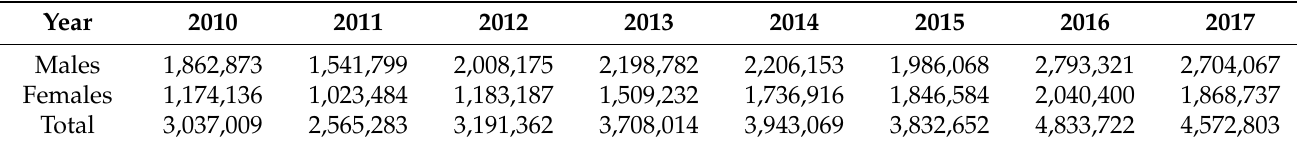
Table 3. Premature mortality cost per sex 2010–2017 (USD